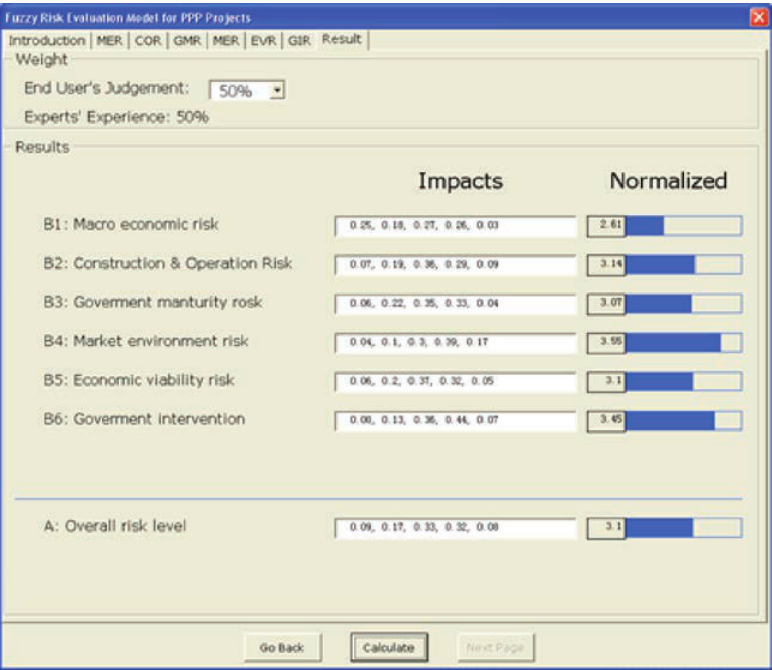
figure 6. risk evaluation result output of Project